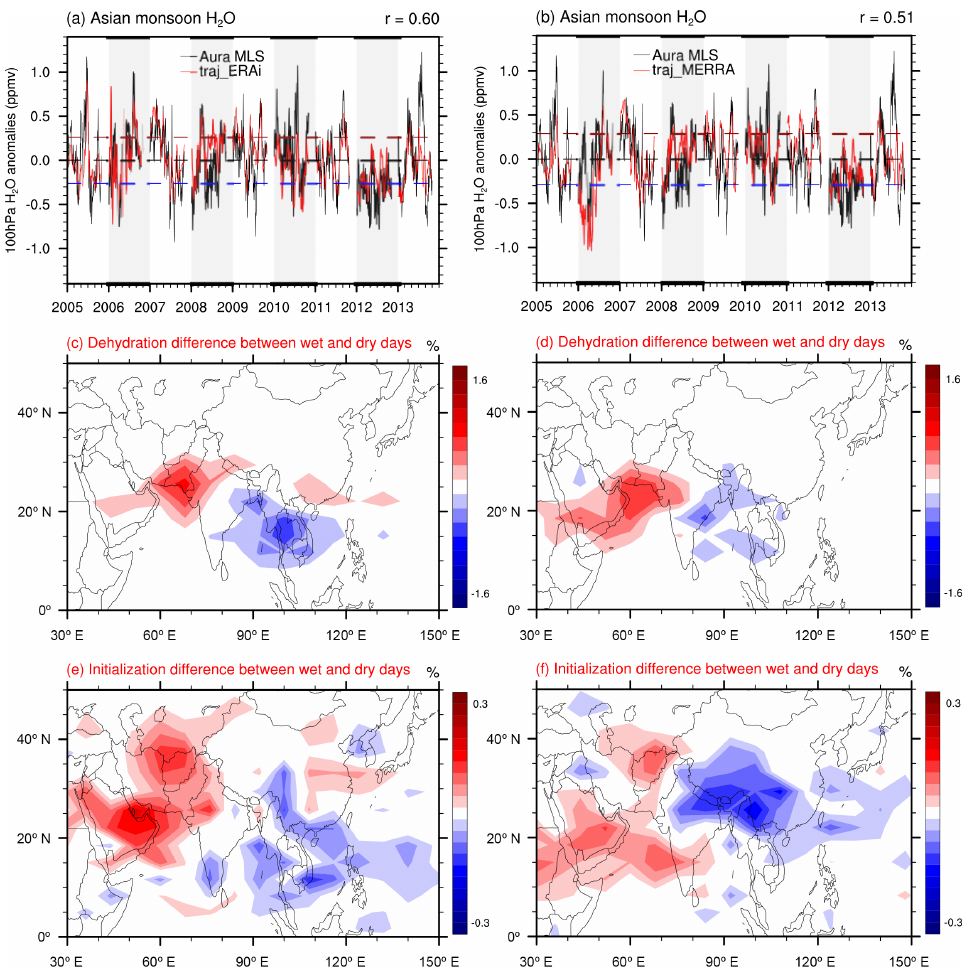
Figure 6. Left panel is from traj_ERAi, right panel is from traj_MERRA. (a, b) Time series of deseasonalized 100hPa water vapor anomalies in the Asian monsoon region (20–40 ◦ N, 40–140 ◦ E) derived from Aura MLS observations (black line) and trajectory runs (red line). Dashed lines are at one sigma variability for water vapor time series in trajectory runs, and are used to identify wet and dry event (above and below 1 standard deviation, denoted by the red and blue dashed lines). (c, d) Anomalous frequency of occurrence of the last dehydration locations between wet and dry days for air parcels located at 100hPa over the Asian monsoon region. (e, f) Same as panels (c, d) but for initialized